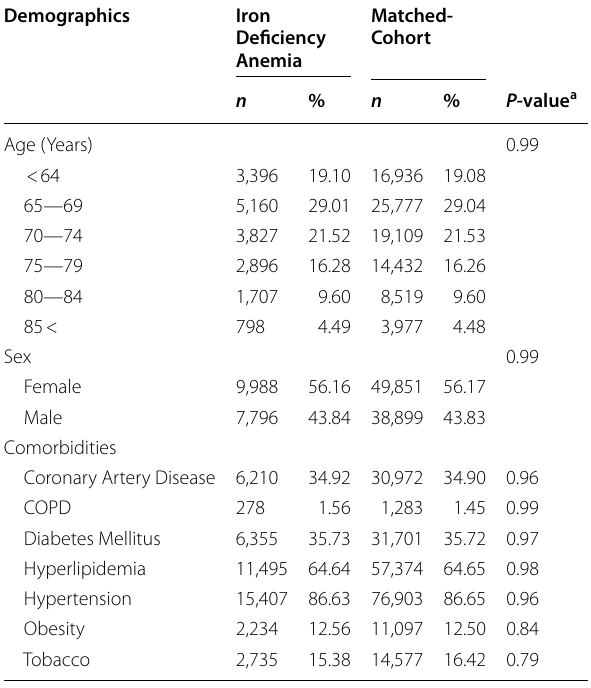
Table 1 Comparison of demographics of patients with iron deficiency anemia and matched-controls undergoing